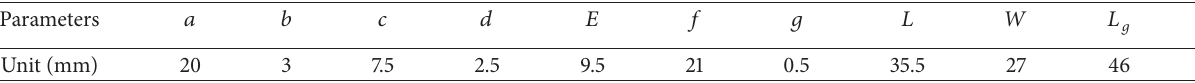
Table 1: Design specification parameters.